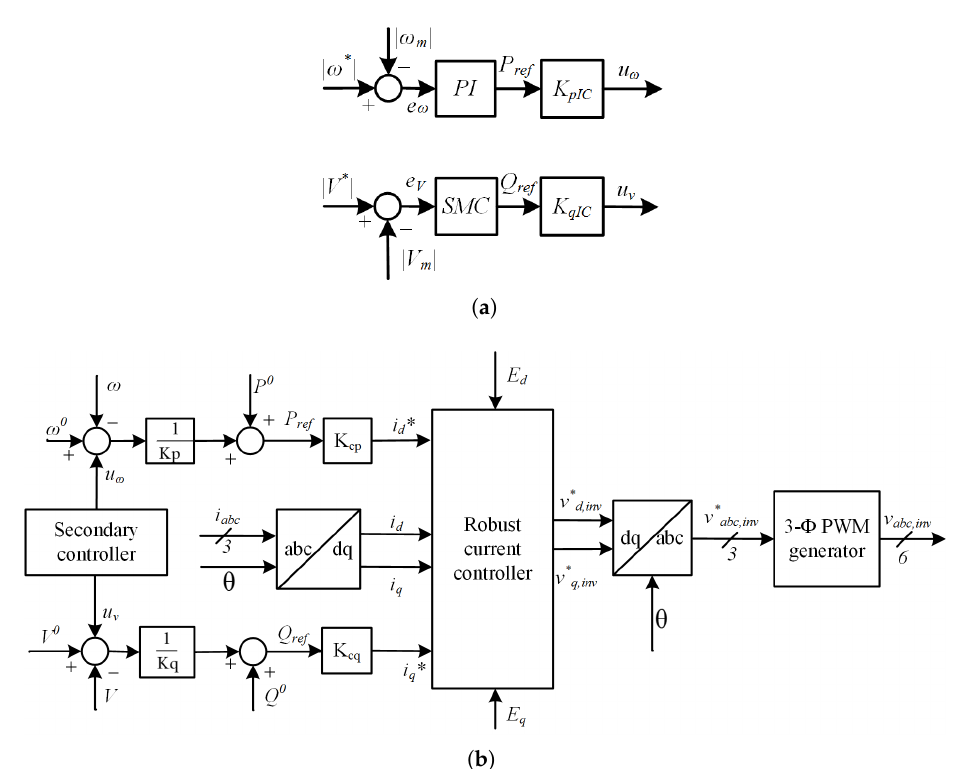
Figure 7. Proposed hierarchical controller block diagrams. ( a ) Proposed secondary controller design. ( b ) Primary current controller